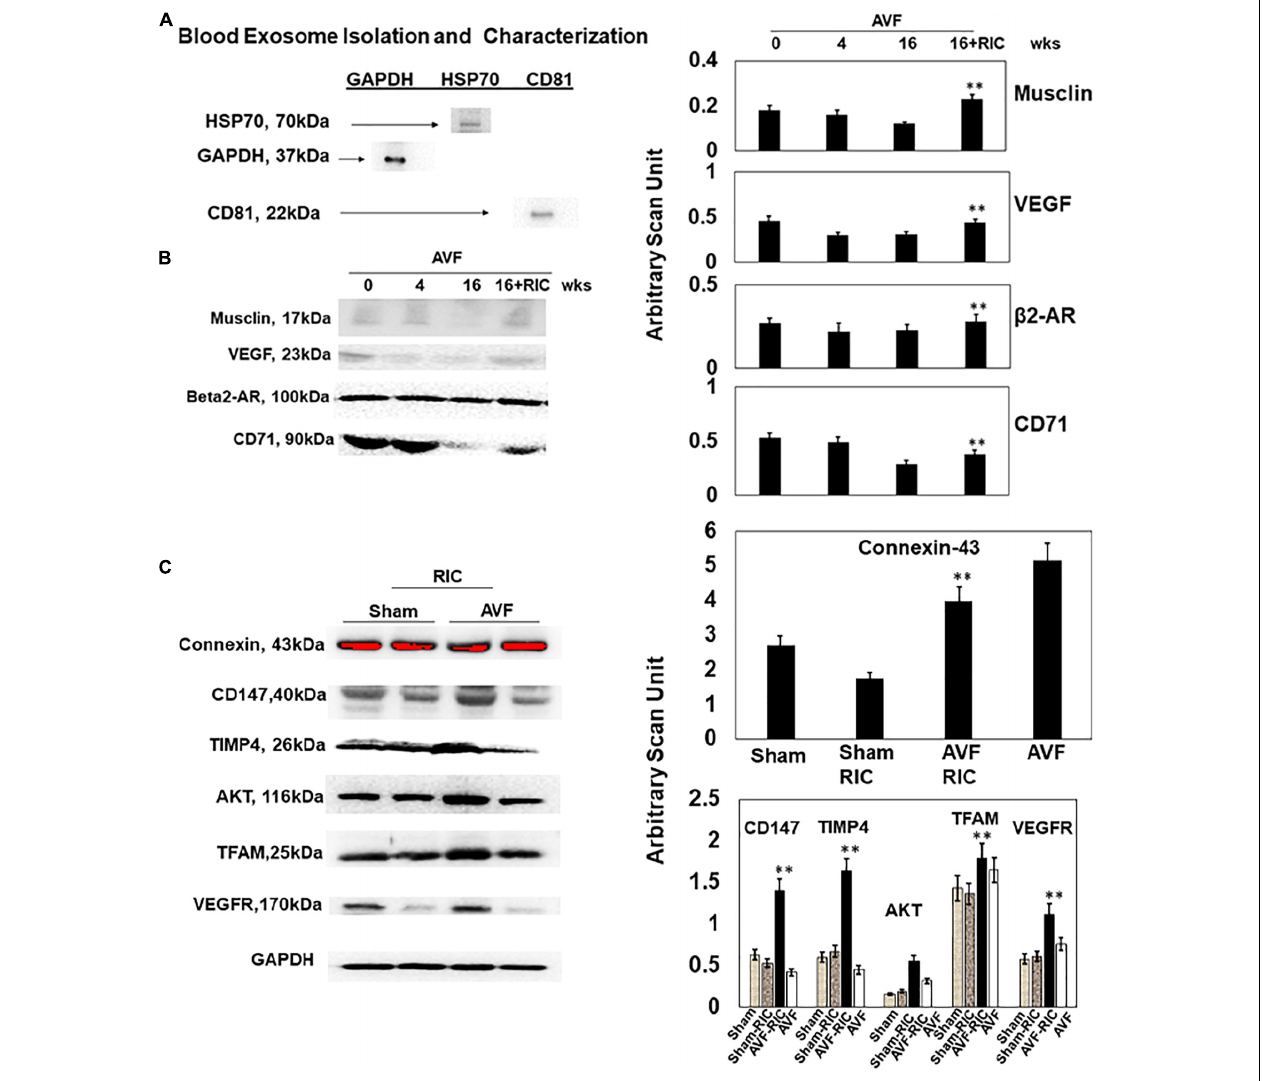
FIGURE 3 | (A) Identification and characterization of exosomes isolated from mouse hearts. Western blot analysis using exosome markers (HSP70, CD81, and GAPDH). (B) Representative Western blot analysis. The blood exosome levels of musclin, VEGF, beta2-AR, and CD71 (a marker of bone marrow stem cell). Bar graph representation of with + SD from n = 5–8 (right panel). (C) The representative Western blot analysis of signaling cardiac levels of connexin-43, EMMPRIN (CD147), TIMP-4, AKT, TFAM, and VEGFR. Right panel: Bar graph representation with ± SD from n = 5–8. ** indicates significant difference ( p < 0.05) either to “0” week or to “sham without